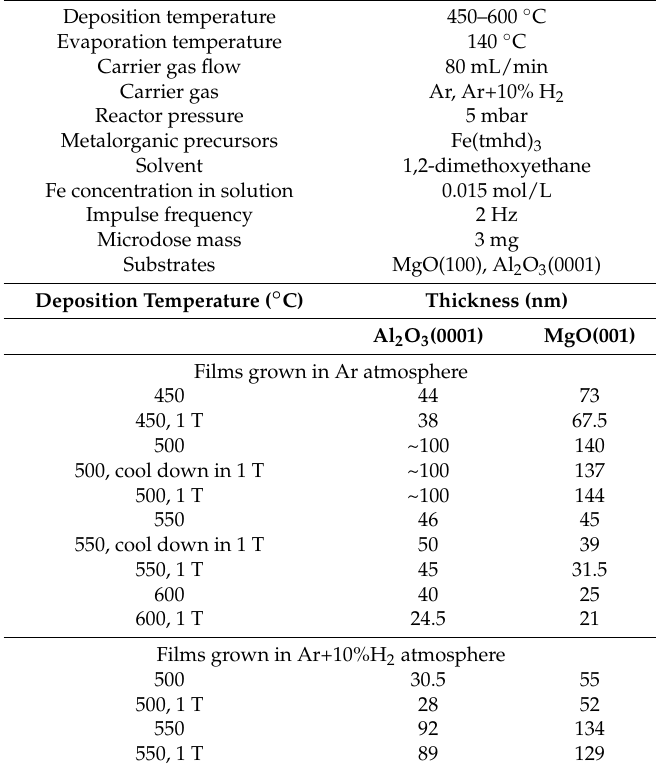
Table 1. Overview of the deposition conditions and Fe 3 O 4 film